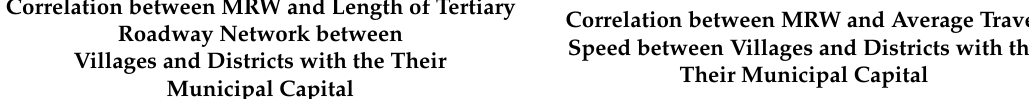
Table 3. R value correlates MRW and length of tertiary roadway network and the average travel speed between villages and districts with their municipal